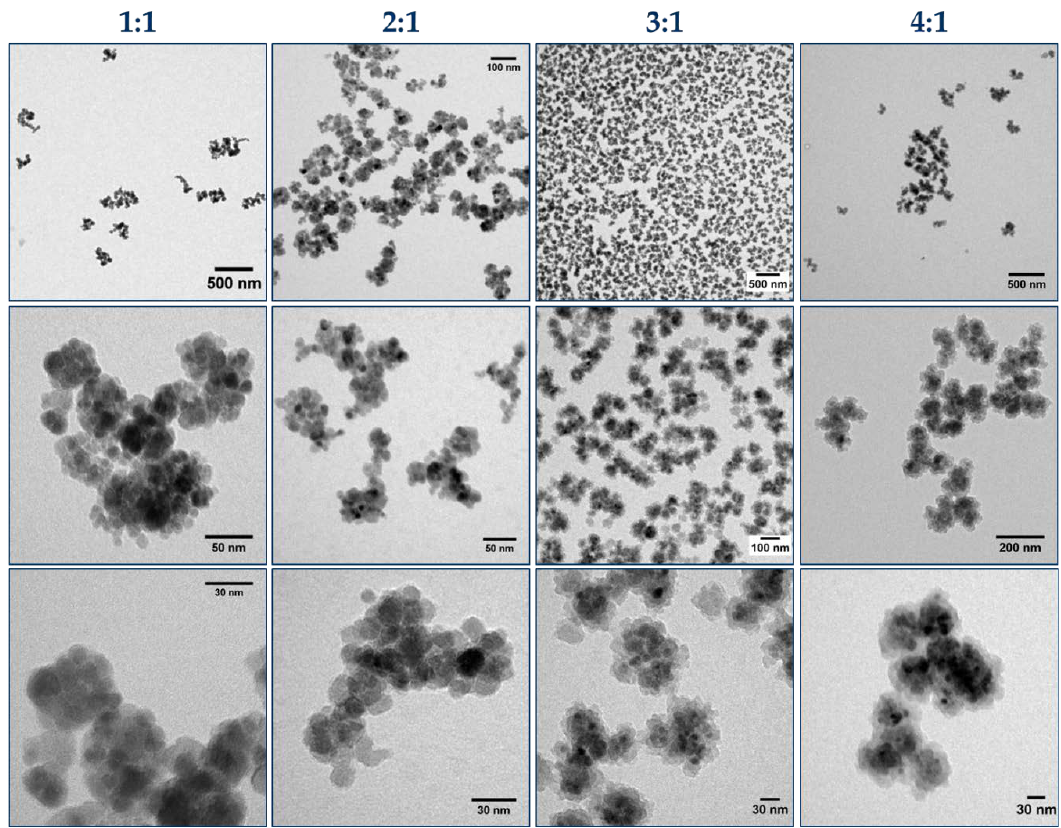
Figure 2. TEM micrographs of MPTS@MCNP obtained from different ratios of MPTS to MCNP at different magnifications.